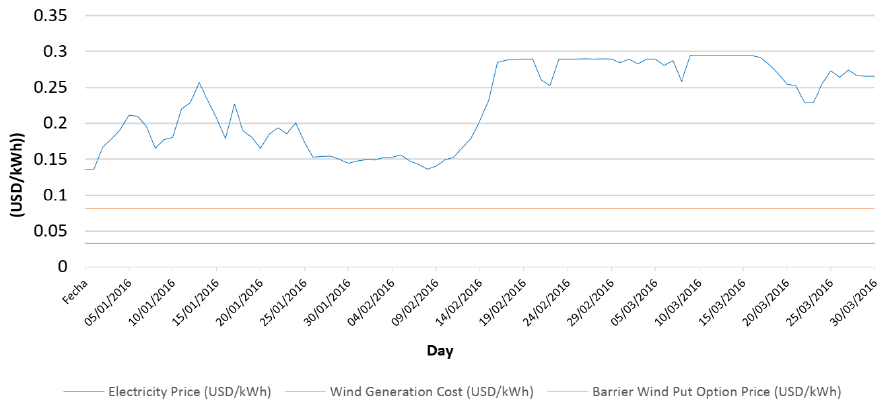
Figure 5. Comparison of electricity prices with the El Niño phenomenon, cost of generation of wind and wind put barrier option price (1 January 2016–31 March 2016).